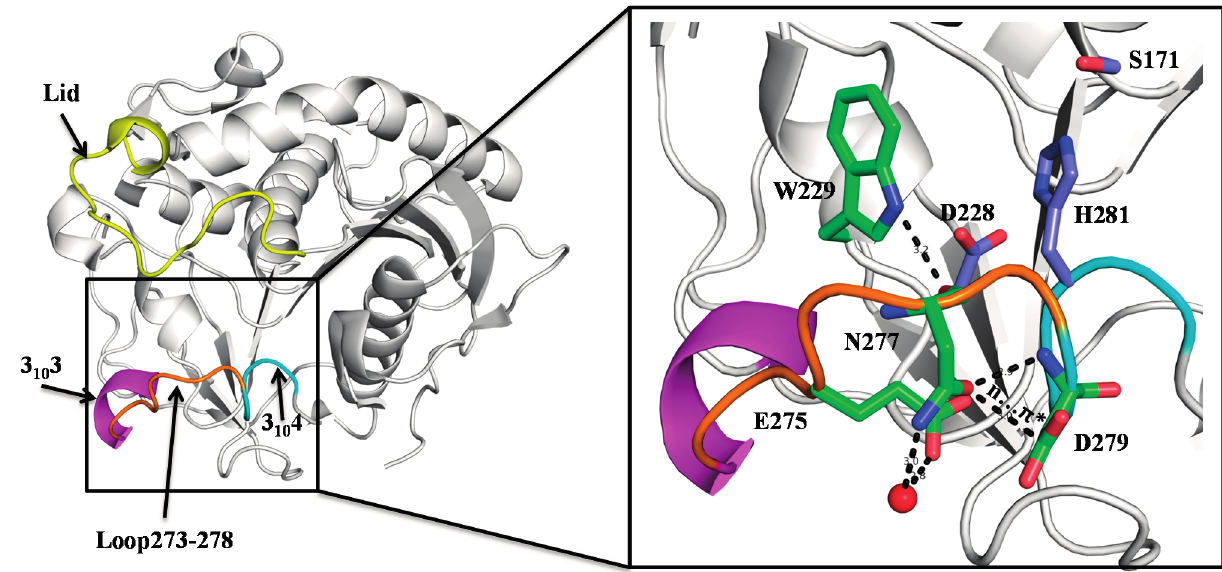
Figure 1. Crystal structure of SMG1 (PDB code: 3UUE, closed form). Lid, 3 10 3 helix, Loop 273–278 and 3 10 4 helix are colored as yellow, magentas, orange and cyan, respectively. The carbon atoms of catalytic triad colored as light blue; the carbon atoms of W229, E275, N277 and D279 colored as green; for all of the displayed residues, oxygen and nitrogen atoms are colored as red and blue, respectively. Water is shown as red